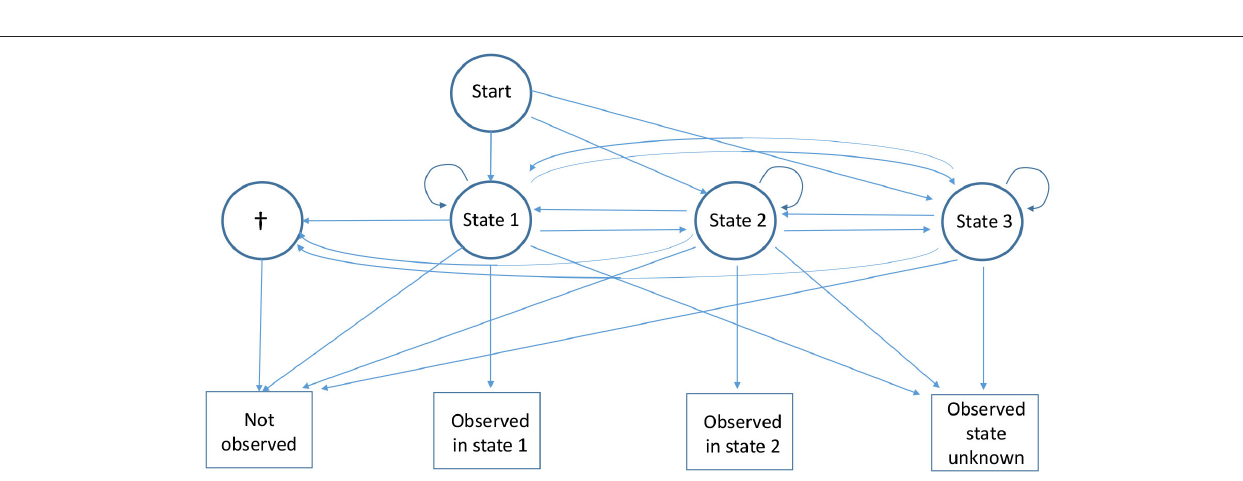
The mixture property is illustrated for a simple example in Table 2 for occasion i = 2 of a T = 4 occasion capture-recapture study with two live states A and B. The number of animals released in state A at occasion 1 first re-captured in a known state at the different occasions, and those never seen again in a known state, follow a multinomial distribution (row 1). Similarly for those released in state B at occasion 1 (row 2), and those first released in an unknown state at occasion 1 (row 3) and at occasion 2 (row